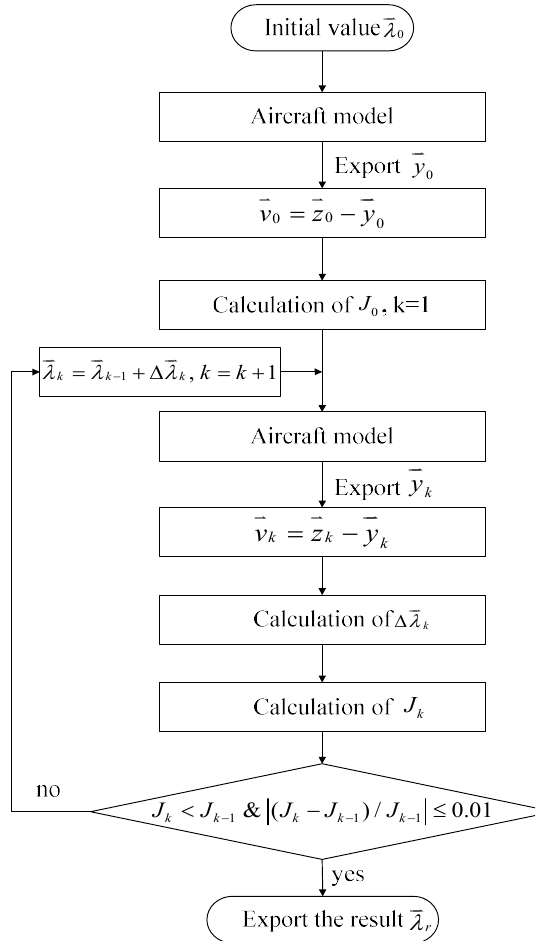
Figure 2. Procedure of the identification program.